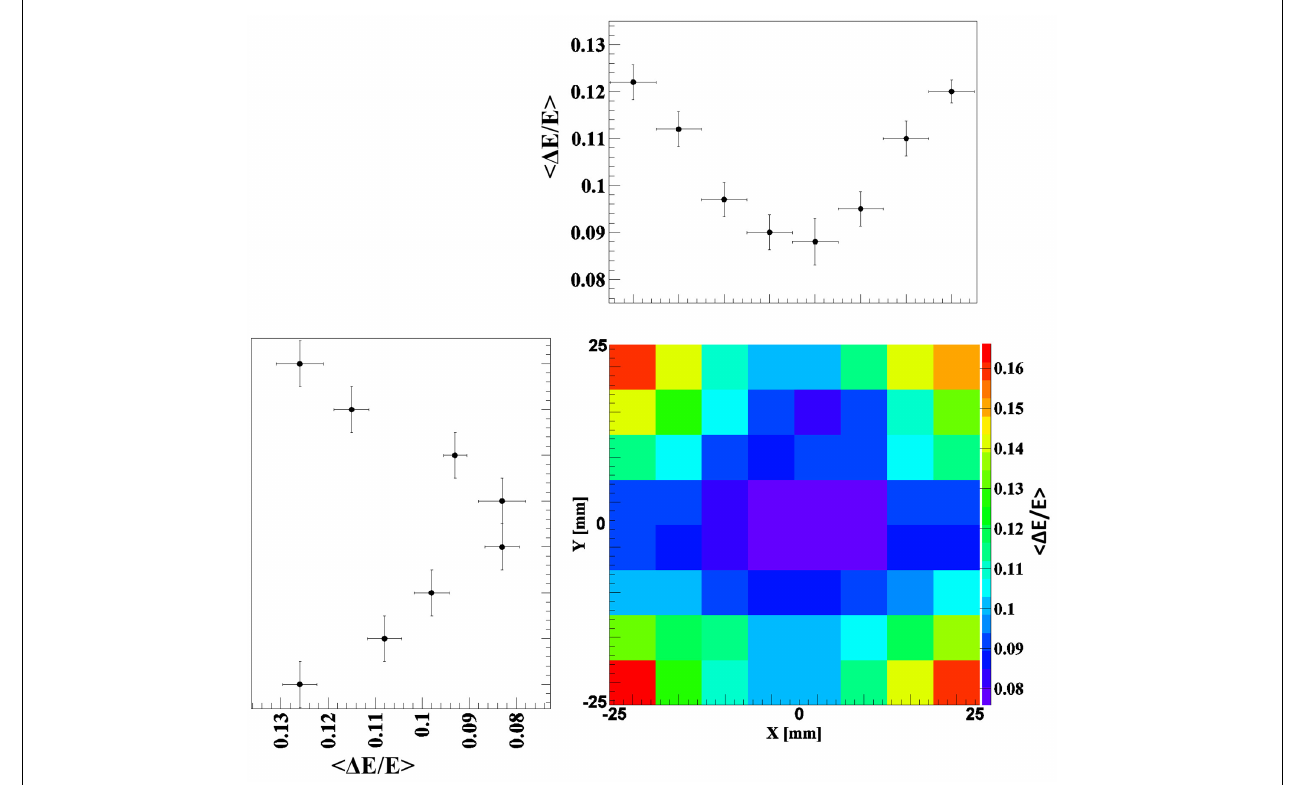
FIGURE 2 | 2D energy resolution map together with its X and Y projection obtained by scanning the absorptively wrapped LaBr 3 :Ce crystal with a 1-mm collimated 137 Cs source and step a size of 6mm in x and y direction .